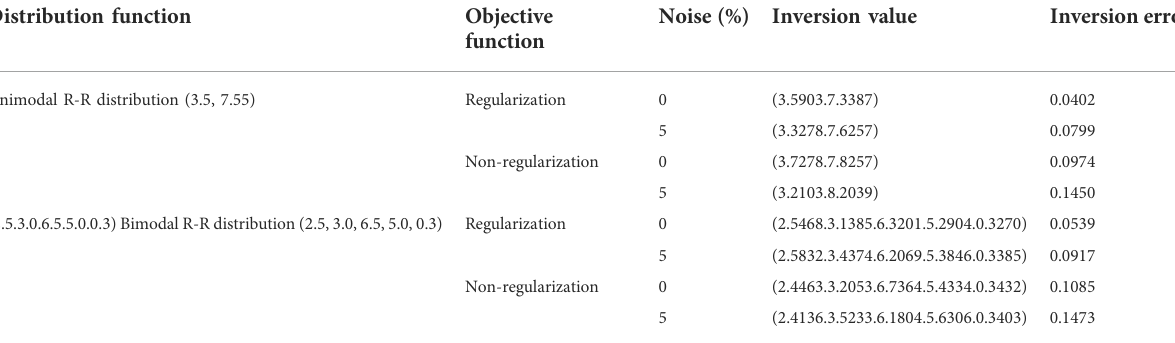
TABLE 3 Comparison of the characteristic parameters and the inversion errors under unimodal and bimodal distribution functions. Distribution